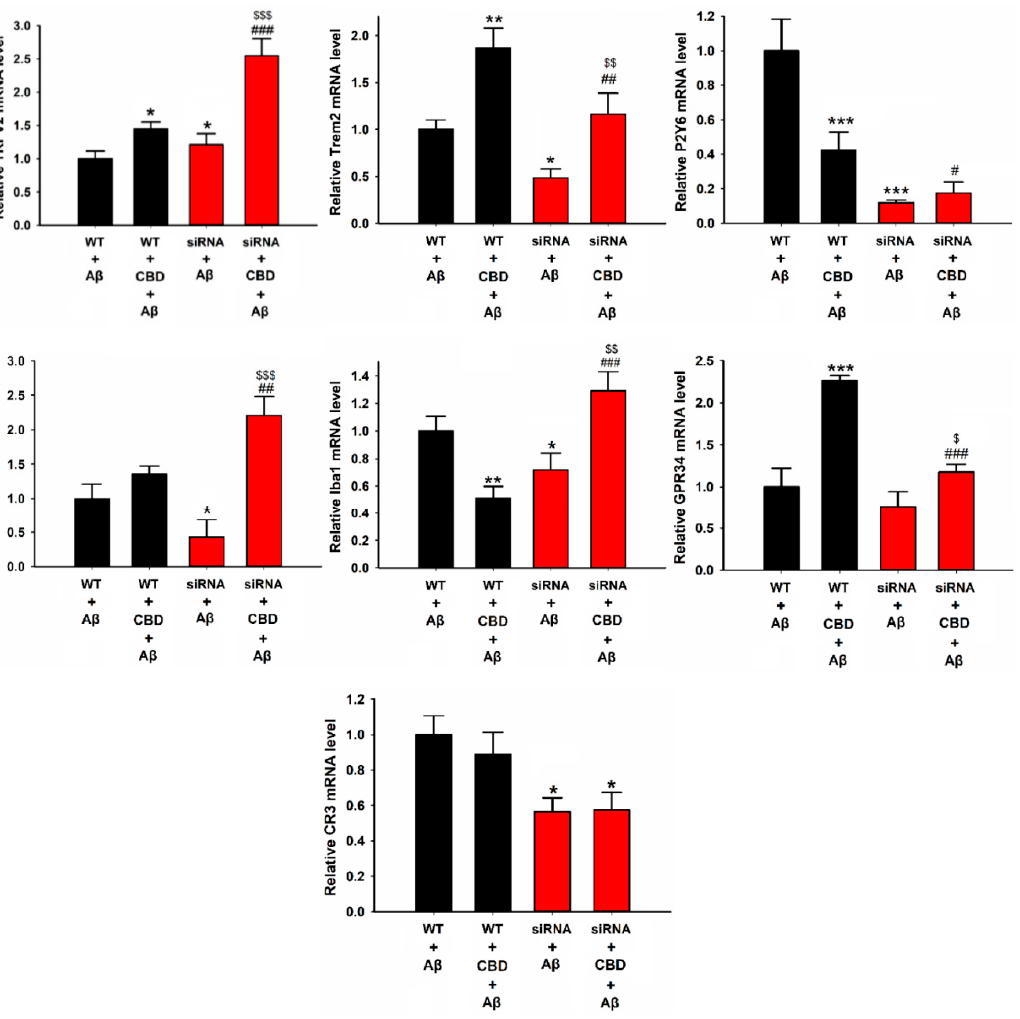
Figure 6. Relative mRNA levels of microglial phagocytic receptors and inflammation factors in microglia cells after knockdown of Trem2. BV2 microglia were treated with or without CBD (5 µ M) after 12 h, and mRNA levels were determined by qPCR. The data are represented as the mean ± SEM ( n = 4). * p < 0.05, ** p < 0.01, and *** p < 0.001 are compared with wild type treated with A β (1 µ g/mL) by Tukey’s